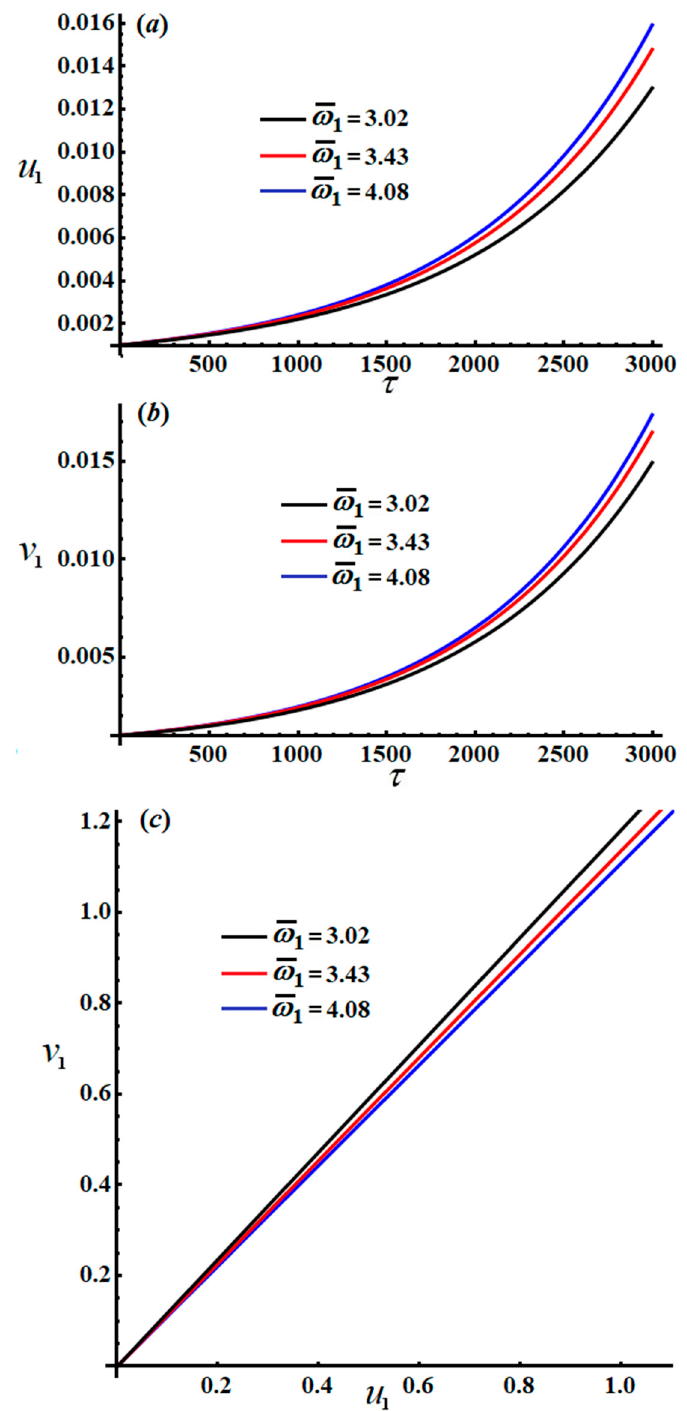
τ Figure 15. The modified amplitudes via and the projections of the modulation equation tracks Figure 15. The modified amplitudes via τ and the projections of the modulation equation tracks on the phase plane u 1 v 1 : ( a – c ) when ω 1 = ( 3.02,3.43,4.08 ) on the phase plane